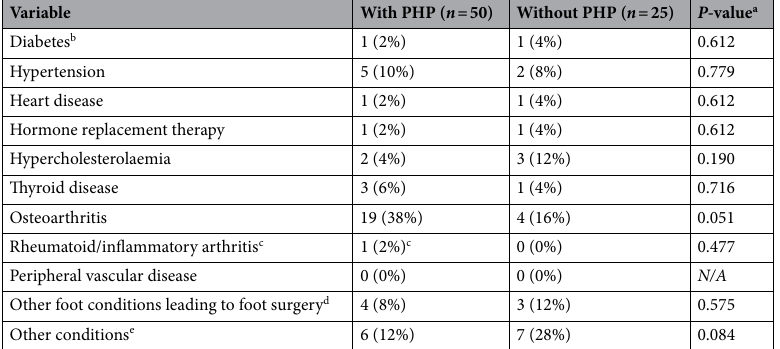
Table 2. Prevalence of comorbidities in the groups with and without PHP. Data provided for groups are number (percentage). N/A = Not applicable—no cases in either group. a P -value relates to Chi-squared test. b Cases did not have any related condition (e.g. diabetic peripheral neuropathy) that affected lower limb sensation or their ability to walk/run. c Case relates to a previous attack of gout—participant had no symptoms or substantial bone abnormality. d Conditions included: calcaneo-cuboid surgery, Achilles tendon surgery, peroneal tendon surgery, Morton’s neuroma surgery, and fractured ankle requiring surgery. Conditions were assessed as to not warrant exclusion. e Conditions included: cataracts, rotator cuff issue, Baker’s